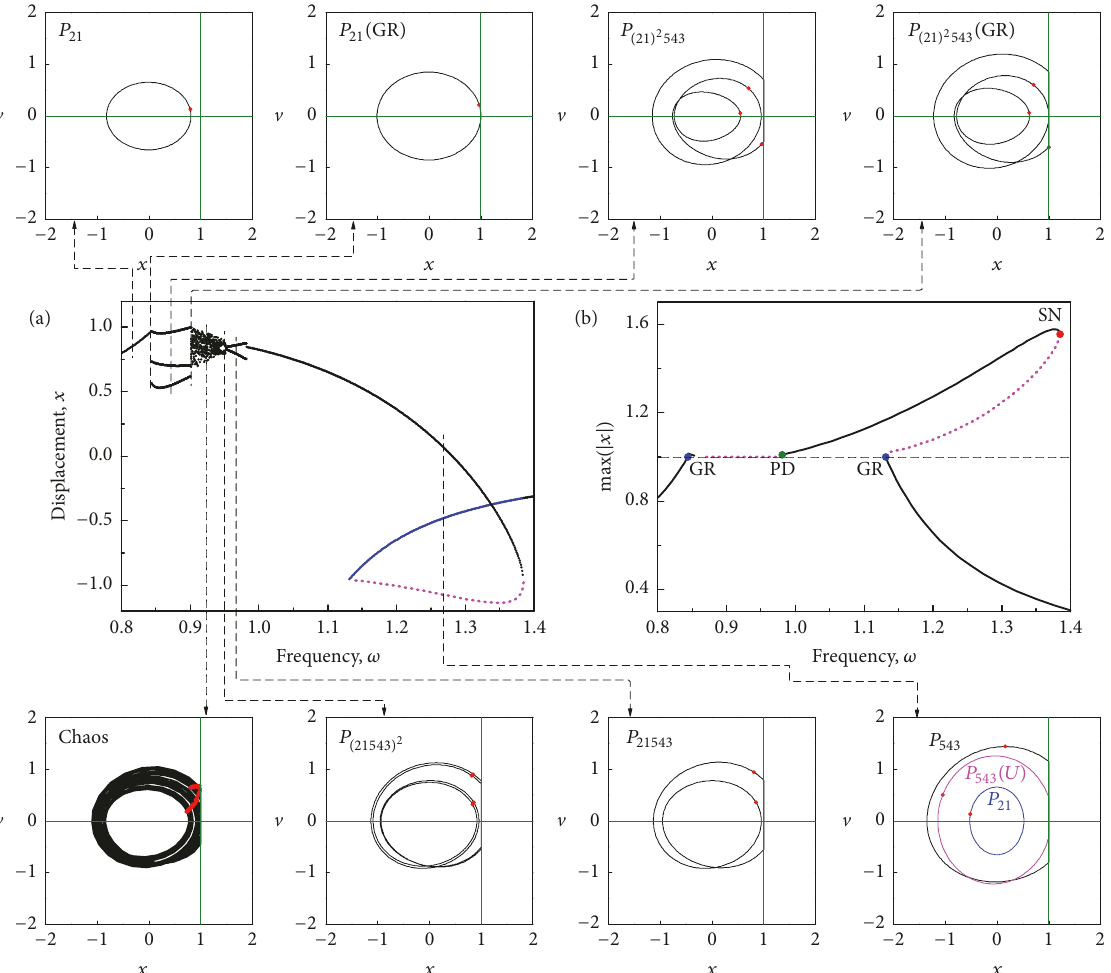
−2−1012 v Figure 3: (a) Bifurcation diagrams constructed for the mass displacement under varying forcing frequency 𝜔 calculated at 𝑎 = 0.3 , 𝑒 = 1 , 𝜉 = 0.05 , 𝜉 = 0.04 , 𝑟 = 0.7 . Black and blue dots mark the mass displacement which is swept in the increasing and decreasing directions, 1 2 respectively. The magenta dots show the unstable period-1 orbit with one impact. Additional windows demonstrate the trajectories of the attractors on the phase plane (𝑥, V ) obtained for 𝜔 = 0.83 , 𝜔 = 𝜔 𝑔1 ≈ 0.84382 , 𝜔 = 0.87 , 𝜔 = 0.90108 , 𝜔 = 0.91 , 𝜔 = 0.95135 , 𝜔 = 0.96 , and 𝜔 = 1.25 (stable impacting period-1 orbit in black, unstable impacting period-1 orbit in magenta, stable nonimpacting period-1 orbit in blue). Green solid lines indicate the location of the discontinuity boundaries 𝑥 = 𝑒 and V = 0 , and the red points show the Poincar´e sections. (b) The corresponding amplitude frequency curve showing the maximum of the absolute values of the mass displacement as a function of the forcing frequency 𝜔 . Blue, green, and red dots represent one-parameter grazing (GR), period-doubling (PD), and saddle-node (SN) bifurcations, respectively. Solid and dotted lines denote stable and unstable solutions, respectively. The dashed horizontal line denotes max ( abs (𝑥)) = 1 . 𝜔 = 0.8 , 𝑒 = 1 , 𝜉 = 0.05 , 𝜉 = 0.04 , 𝑟 = 0.7 , 1 2